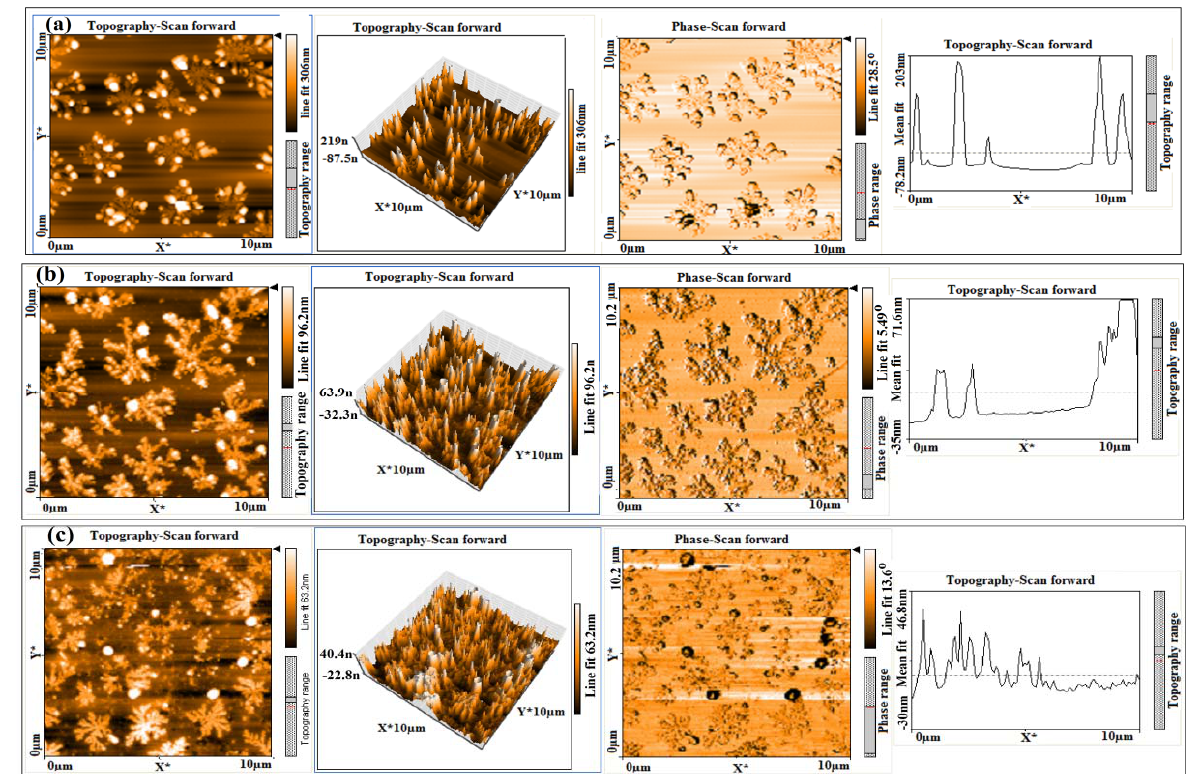
Fig. 6. (a) AFM images of pure TiO nanorods pure state. (b) doped state with 6 h reflux time and 2 (c) doped state with 12 h reflux